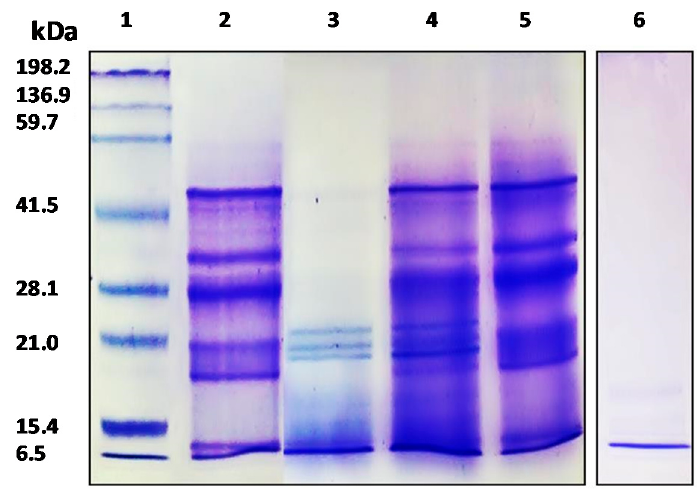
Figure 1. SDS-PAGE electrophoresis analysis of APC and its gastrointestinal hydrolysates. 1: molecular weight standard; 2: APC; 3: gastric hydrolysate (pH 1.2); 4: gastric hydrolysate (pH 2.0); 5: gastric hydrolysate (pH 3.2); 6: Gastrointestinal hydrolysate (pepsin pH 3.2 and pancreatin pH 7.0).